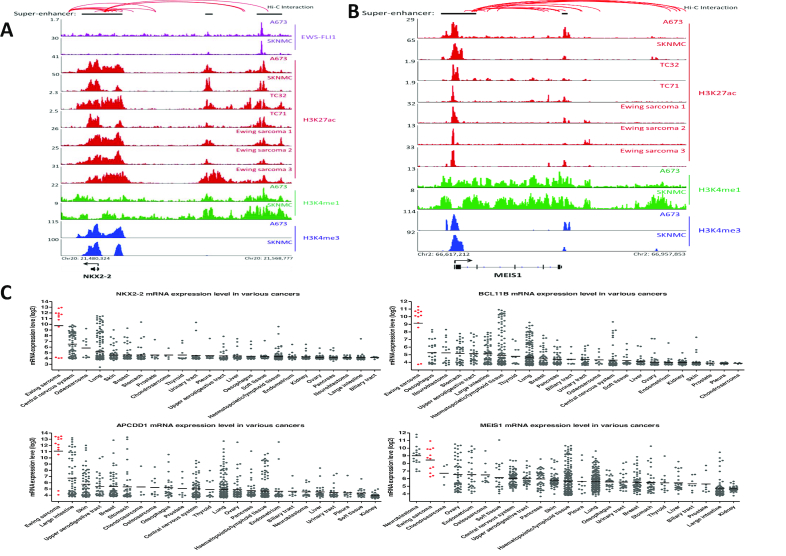
Nomination of super-enhancer-associated transcripts in Ewing sarcoma, (A, B) ChIP-seq profiles of EWS-FLI1, H3K27ac, H3K4me1 and H3K4me3 at representative super-enhancer-associated gene loci across Ewing sarcoma cell lines and primary tumors. Y axis represents the value of reads per million per base pair (rpm/bp). Above the ChIP-seq profiles were interactions among cis-regulatory elements in SKNMC cells predicted by Hi-C from ENCODE project, and visualized using public browser (http://promoter.bx.psu.edu/hi-c/index.html). (C) Data retrieved from CCLE project depicting mRNA expression of representative super-enhancer-associated transcripts across various types of human cancer cells.